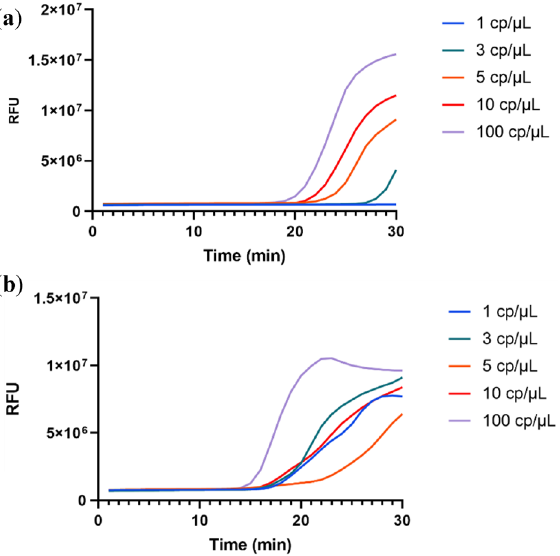
Figure 2. ( a ) Real-time fluorescence signal for the amplification of synthetic RNA controls using a 3-primer set with 40 mM of Guanidine HCL in the RT-LAMP reaction. ( b ) Amplification of synthetic RNA controls using a